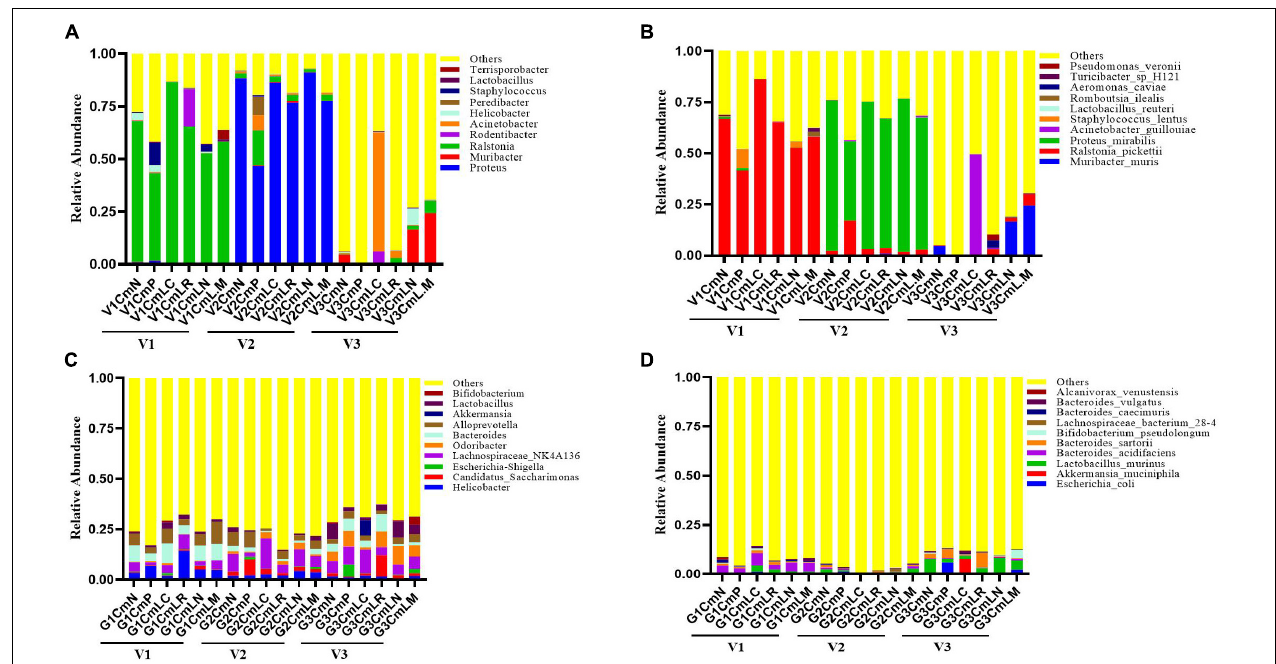
FIGURE 8 | Taxonomic composition of the vaginal and intestinal microbiota. Both vaginal and intestinal swab samples were carefully collected at Visit 1 (V1: pre-medroxyprogesterone injection and chlamydia infection), Visit 2 (V2: 14 days after chlamydia infection), and Visit 3 (V3: 80 days after chlamydia infection). Stacked bar charts of top 10 taxa in terms of relative abundances at the genus (A,C) and species (B,D) levels for vaginal and intestinal microbiota, respectively. Remaining taxa are grouped in the “Other” category. Each mouse was intravaginally inoculated with SPG alone (CmN), or live C. muridarum. On Day 3 postinfection, the mice were given either an MRS medium (CmP), L. crispatus (CmLC), L. reuteri (CmLR), L. iners (CmLN), or a mixture of these bacteria (CmLM) at a ratio of 1:1:1 intravaginal